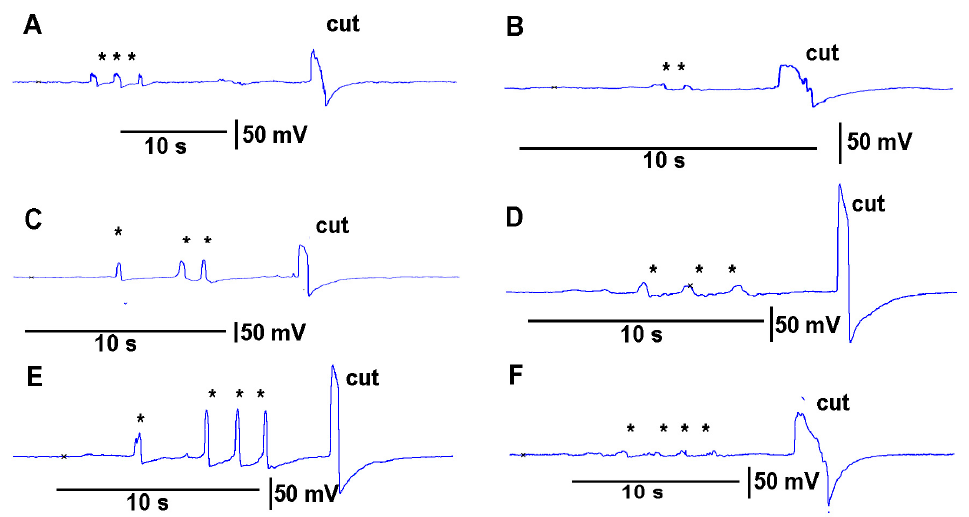
Figure 8. The effect of bending a leaf and cutting the same leaf while measuring the impedance changes by recording with both leads placed within the stem of eggplants. ( A-F ) illustrates six different plants.The asterisk (*) shown in each recording demarcates a bending of the leaf as a test for the effect of movement on the leaf which occurs while cutting a leaf.